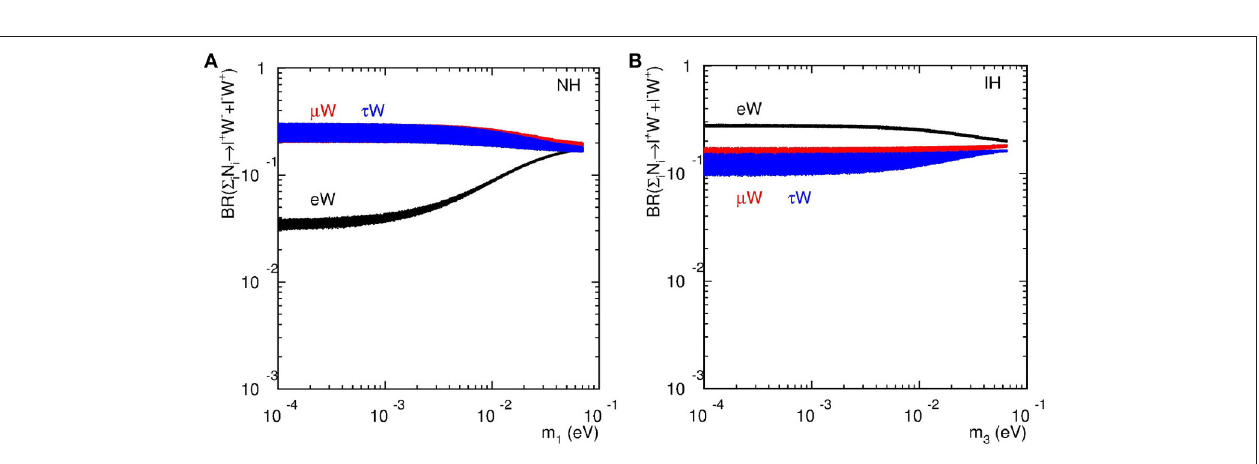
FIGURE 3 | Branching fractions of process i N i → ℓ + W − + ℓ − W + vs. the lightest neutrino mass for (A) NH and (B) IH in the degenerate case with M N = 300 GeV and m h 125 GeV, assuming vanishing P =